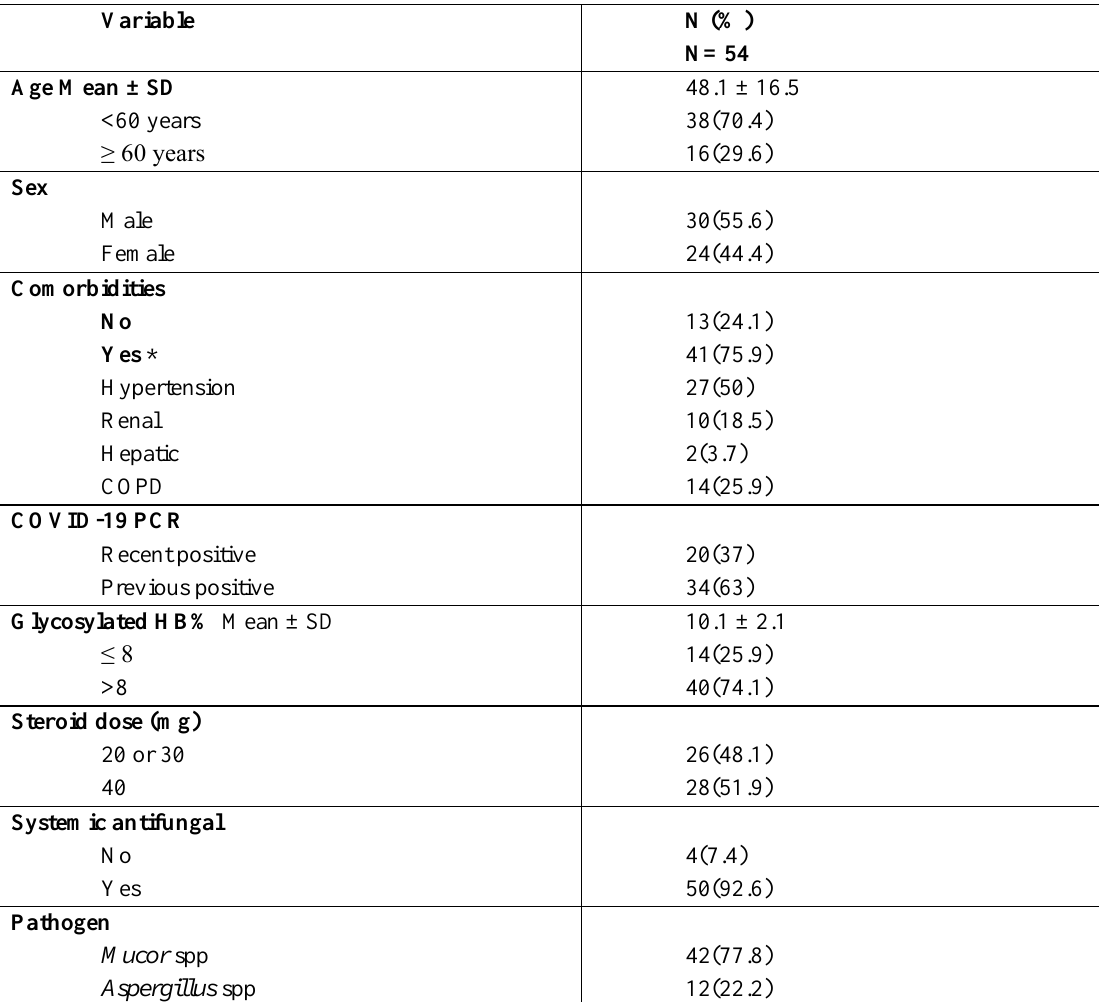
Table 1. Clinical, sociodemographic data, associated comorbidities, causative agents and risk factors of AIFRS patients with COVID-19 infection.